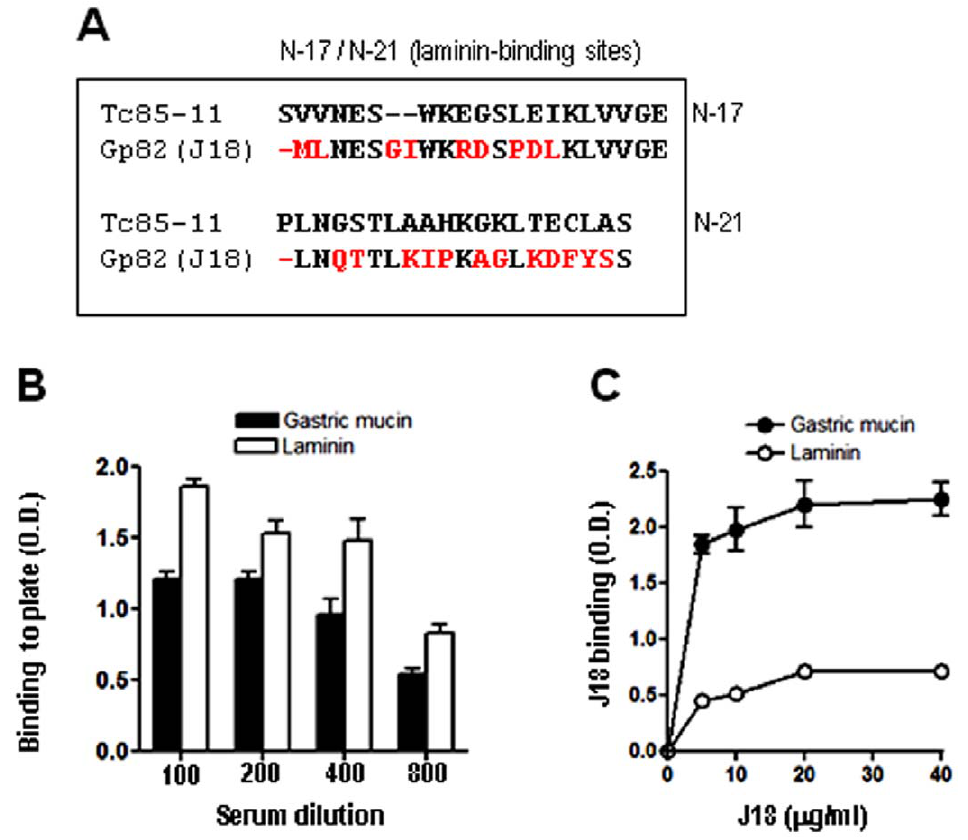
Figure 3. Comparative analysis of Tc85-11 sequences mapped as laminin-binding sites and the equivalent sequences in gp82. A) The Tc85-11 sequences N-17 and N-21, corresponding to laminin-binding sites, were aligned with the equivalent sequences in gp82, with the differences highlighted in red. B) Microtiter plates were coated with laminin or gastric mucin (10 m g/well), and ELISA assay was performed using anti- laminin or anti-gastric mucin antisera, at the indicated dilutions. C) Laminin- or gastric mucin-coated plates were incubated with J18, the recombinant protein containing the full length gp82 sequence, at the indicated concentrations. Binding of J18 was revealed by anti-J18 antibodies. Values are the means 6 SD of triplicates of a representative experiment.